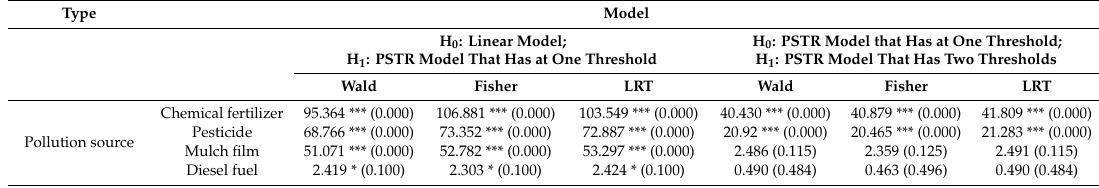
Table 3. Threshold e ff ect test of the pollution sources